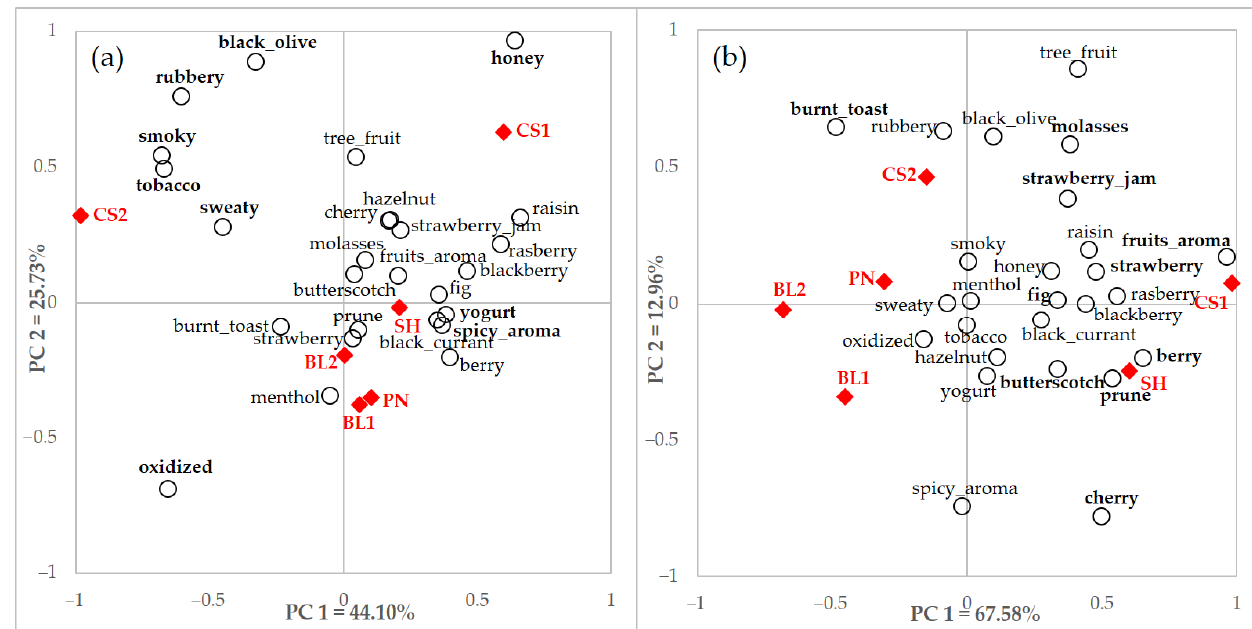
Figure 5. Principal component analysis (PCA) of ( a ) users and ( b ) non-users data with integrated significant terms ( n = 26) by rating questionnaire of total consumers, users, and non-users. Filled diamonds indicate red wine samples and empty circles indicate attributes. Terms in bold indicate significant differences according to each consumer group with different familiarity.